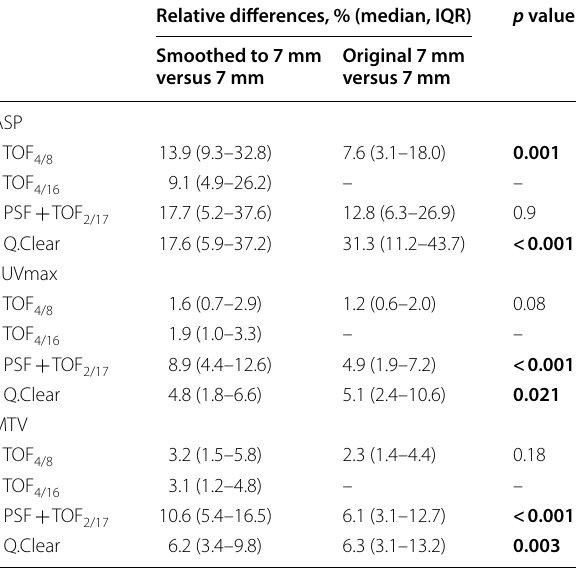
Table 4 Relative differences to the reference algorithm: smoothed